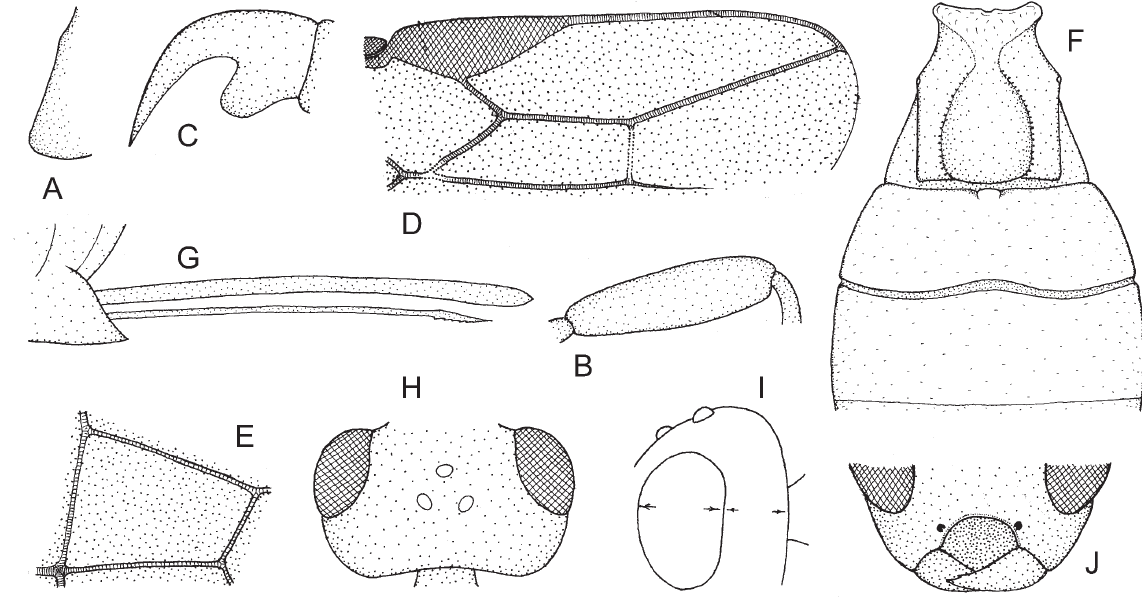
Fig. 42. Bracon ( Glabrobracon ) praecox Wesmael, 1838 (A-G: ♀ holotype, H-J: ♀ / ♂). A . Propleuron in lateral view. B . Hind femur. C . Claw. D . Distal part of right forewing. E . First discal cell of right forewing. F . Tergites 1-3. G . Hypopygium and ovipositor apparatus. H . Head in dorsal view. I . Head in lateral view. J . Head in frontal